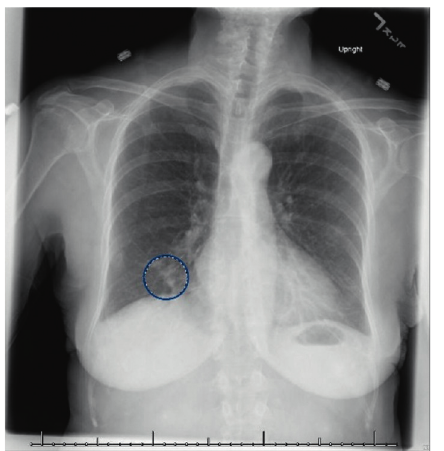
Figure 5: PA chest radiograph showing confluent opacity in the right lower